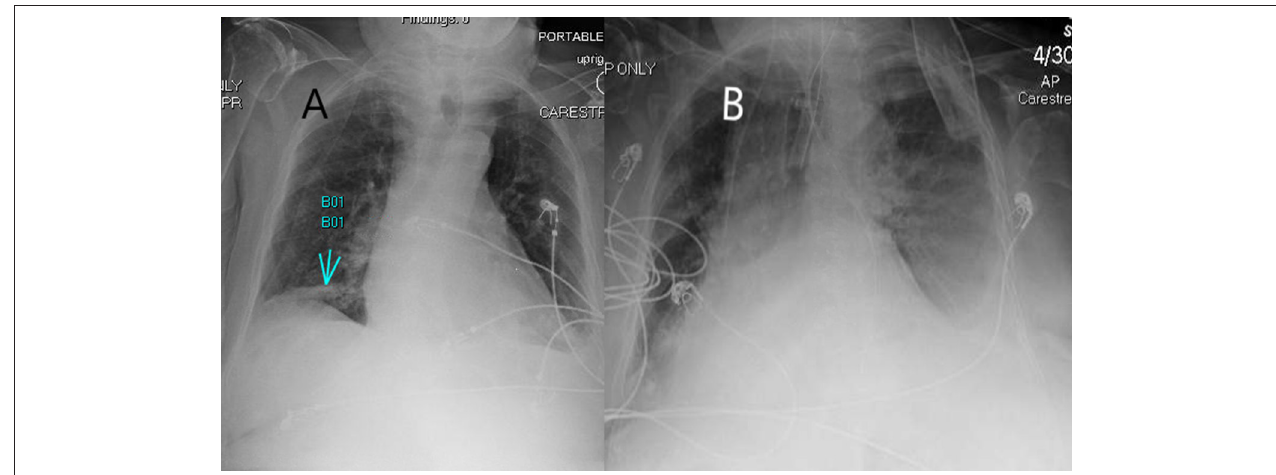
FIGURE 1 | A 82-year-old woman presented to the emergency department with cough, shortness of breath, altered mental status. (A) X-ray showing a right lower lobe infiltrate (arrow) on day 1 and tested positive for COVID-19 using PCR. Later, due to worsening respiratory function and confusion, the patient was admitted to the intensive care unit and was intubated. (B) Image showing small left pleural effusion with worsening infiltrates.